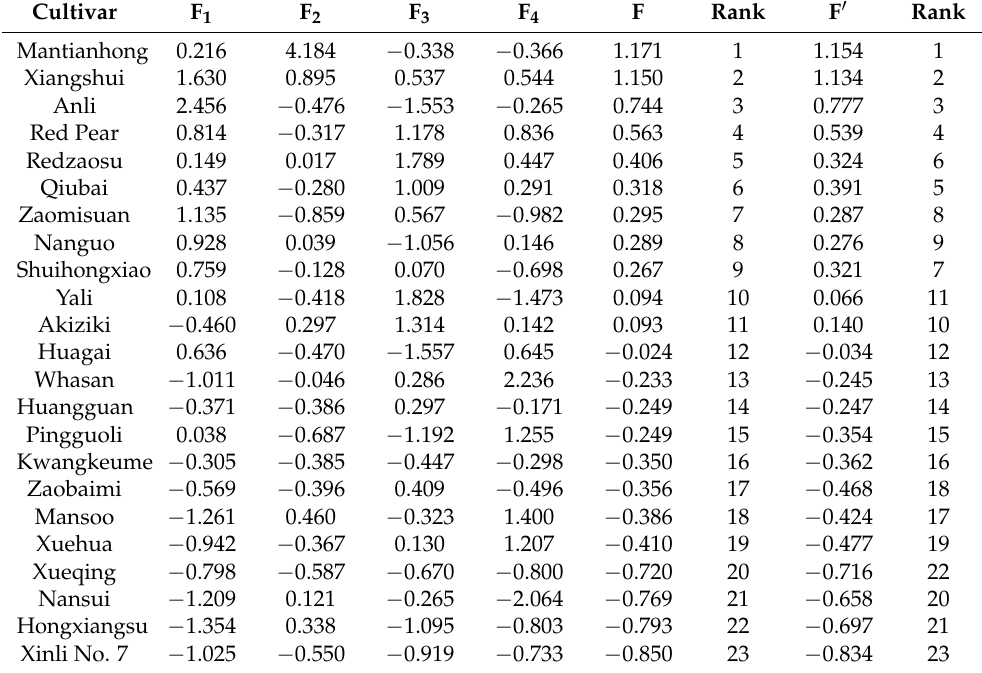
Table 6. Factor matrix including loadings, eigenvalues, percent of variance and cumulative variance for the first four principal